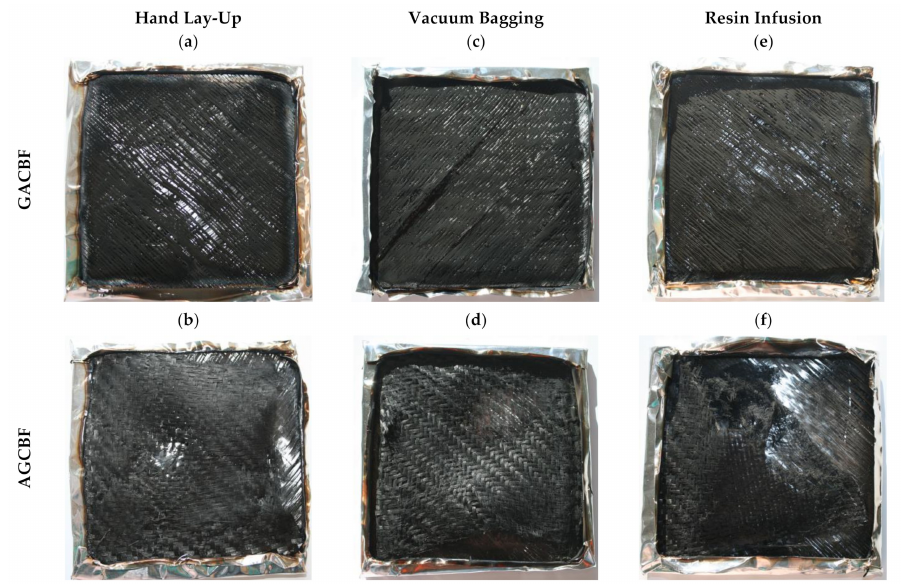
Figure 6. Photographs of GCABF ( a ), CGABF ( b ), CAGBF ( c ), MAGCBF ( d ), VGACBF ( e ), MGACBSF ( f ) after cone calorimetry